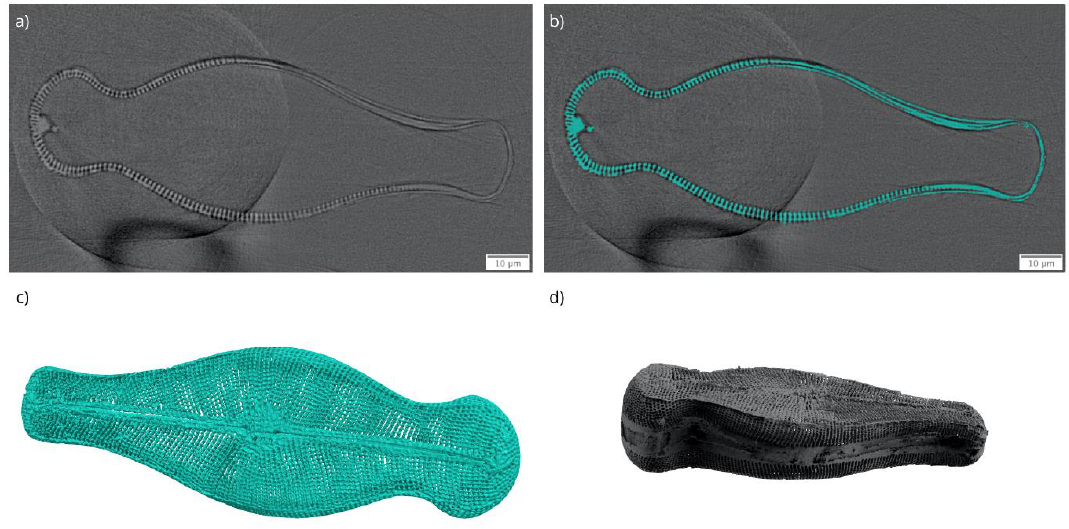
Figure 7. ( a ) Reconstructed nano-XCT data, ( b ) segmentation field, ( c ) consequent 3D visualization of segmented data, and ( d ) the surface mesh of studied Didymosphenia geminata frustule.